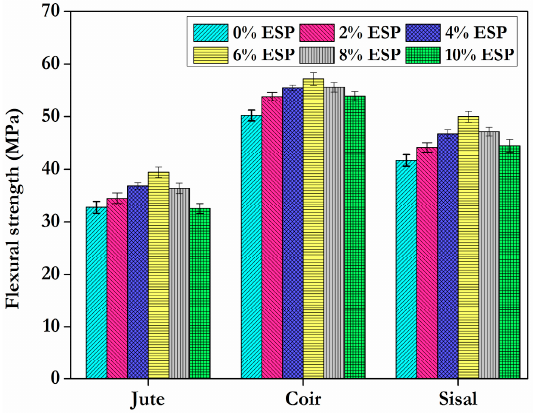
Figure 8. Flexuralstrength of composites.